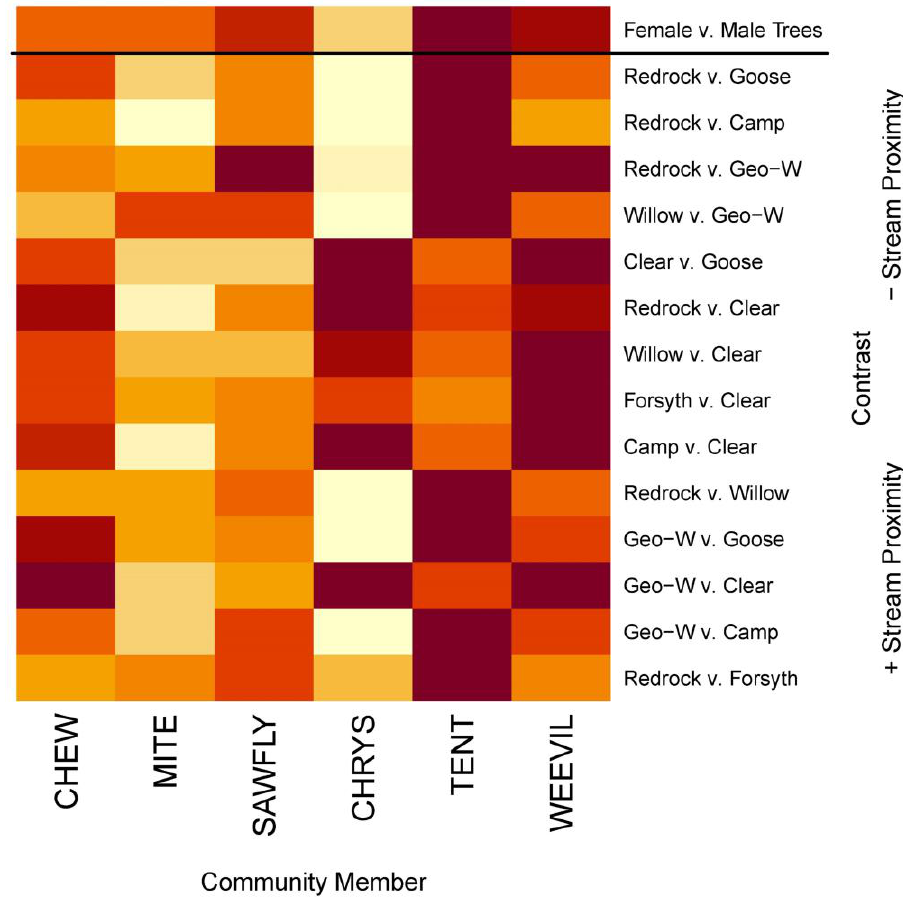
Figure 4. Heatmap highlighting the most important willow-dependent community members that drove observed differences for willow sex (contrast above) and stream comparisons from our SIMPER analyses (Table S6). Darker red colors represent more important community members for a given comparison. “+Stream Proximity” indicates stream comparisons that are geographically closer together, while “−Stream Proximity” indicates those farther apart. Abbreviations: CHEW represents unidentified chewing guild arthropods, CHRYS represents chrysomelid beetles, and TENT represents tent caterpillars.